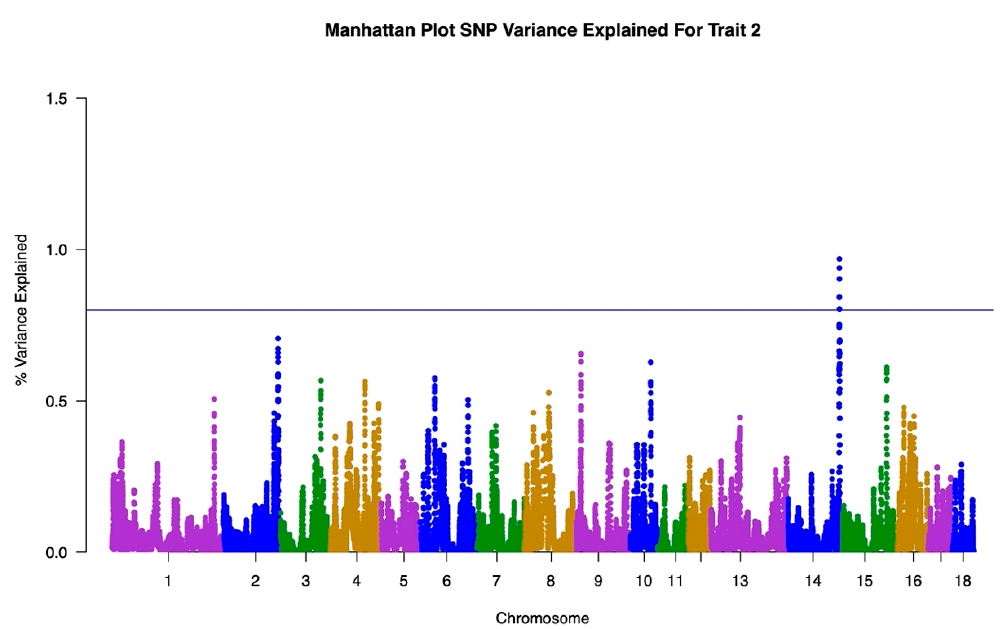
Figure 2. Manhattan Plot representing the Genome-Wide Association Study results for Trait Two, referring to HCW under thermos-neutral conditions. Chromosomes listed on x axis and percentage of variance explained listed on the y axis.